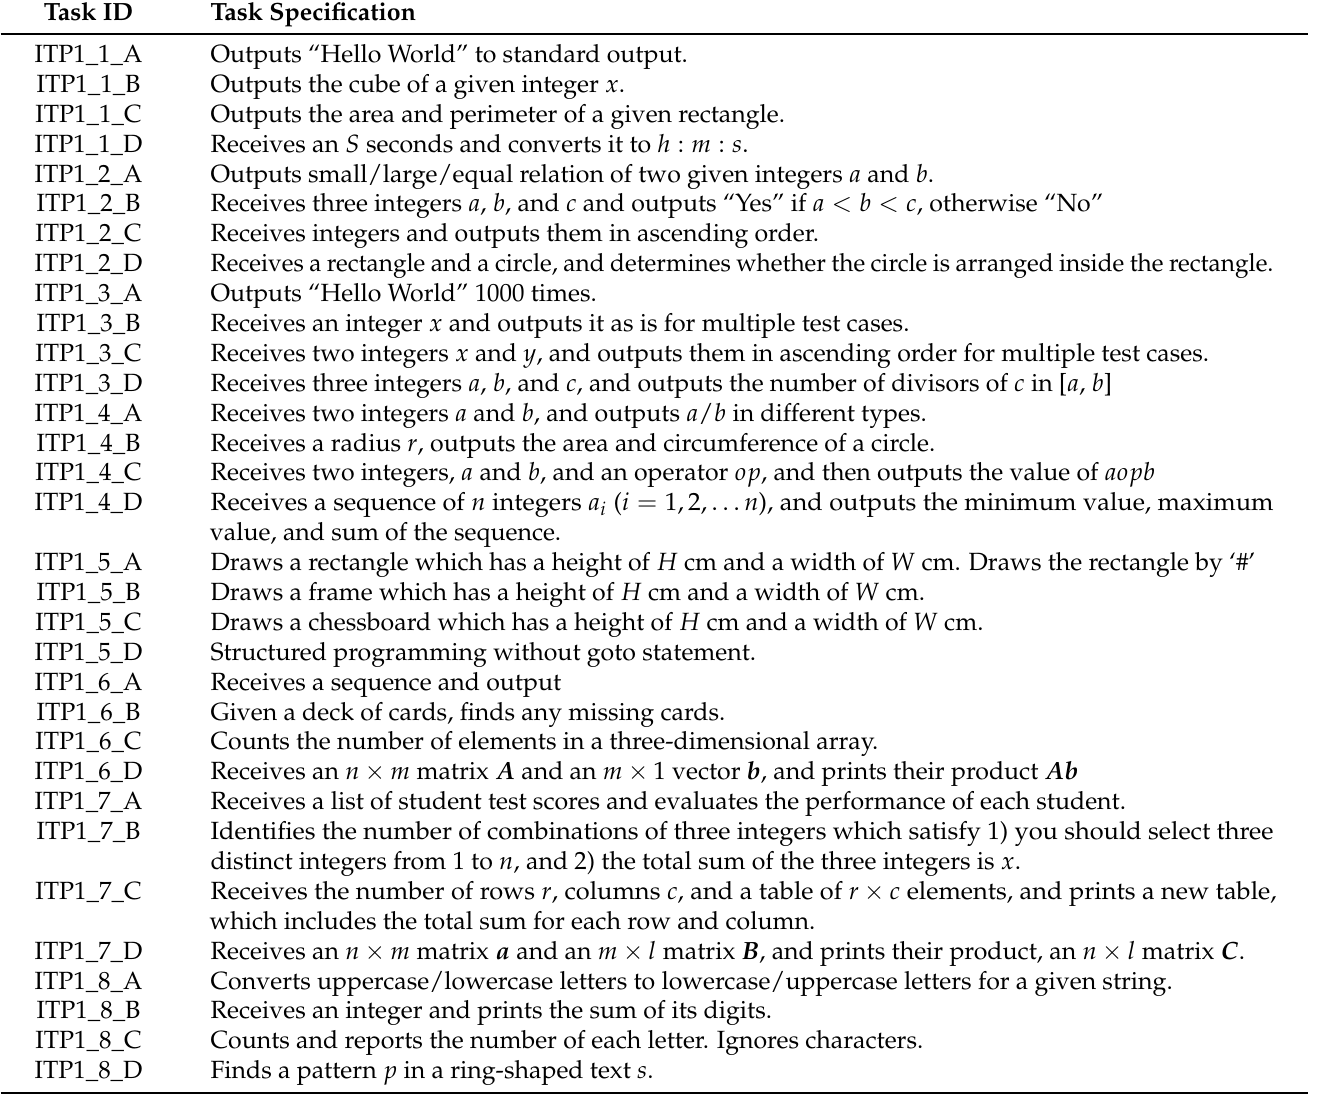
Table 1. Details of 32 selected